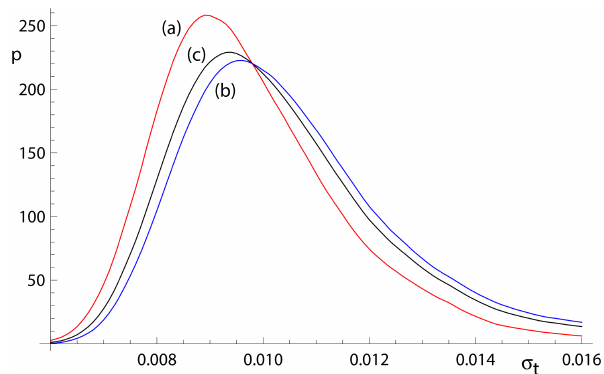
Figure 4. Kernel density estimates ( kde ) for age uncertainty cal- culated with SPINE on 10000 simulated datasets with n = 10 and Gaussian-distributed uncertainties. (a) Those datasets for which all | r k | < h (in red); (b) those datasets for which at least one | r k | > h (in blue), and (c) overall result combining panels (a) and (b) in ob- served proportion (in black).